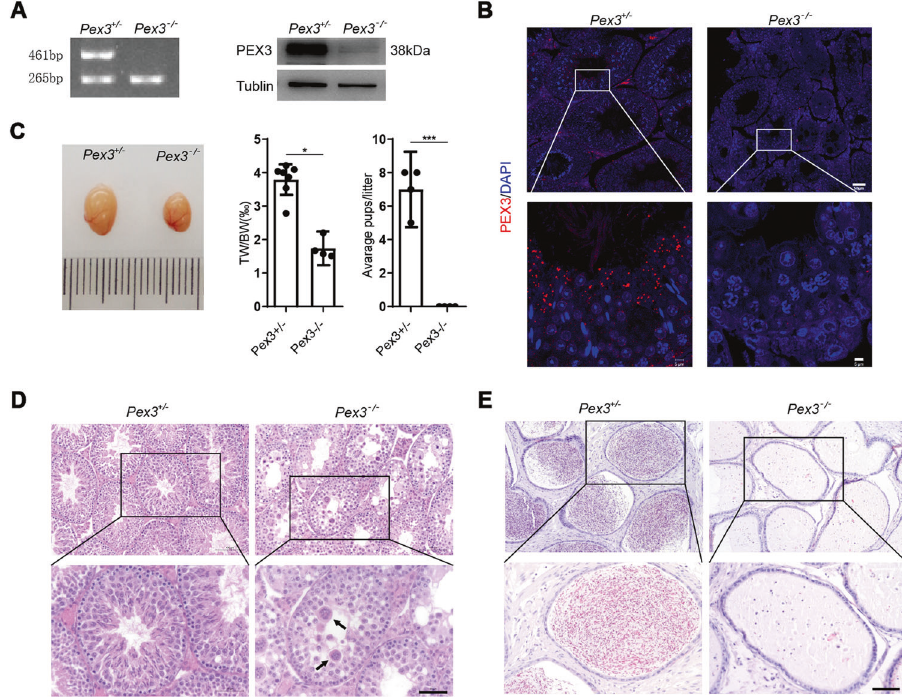
Fig. 1 Phenotypic validation of Pex3 -KO mice. ( n = 4 – 7). A Mouse tail DNA agarose gel electrophoresis and testicular protein immunoblotting; tubulin was used as an internal control. B PEX3 immuno fl uorescence (red) staining of testicular tissue. Scale bars: 5 μ m. C Representative testicular morphology, testicular weight ratio (TW/BW), and natural reproduction results. D – E HE staining of the testis and epididymis. Scale bars: 50 μ